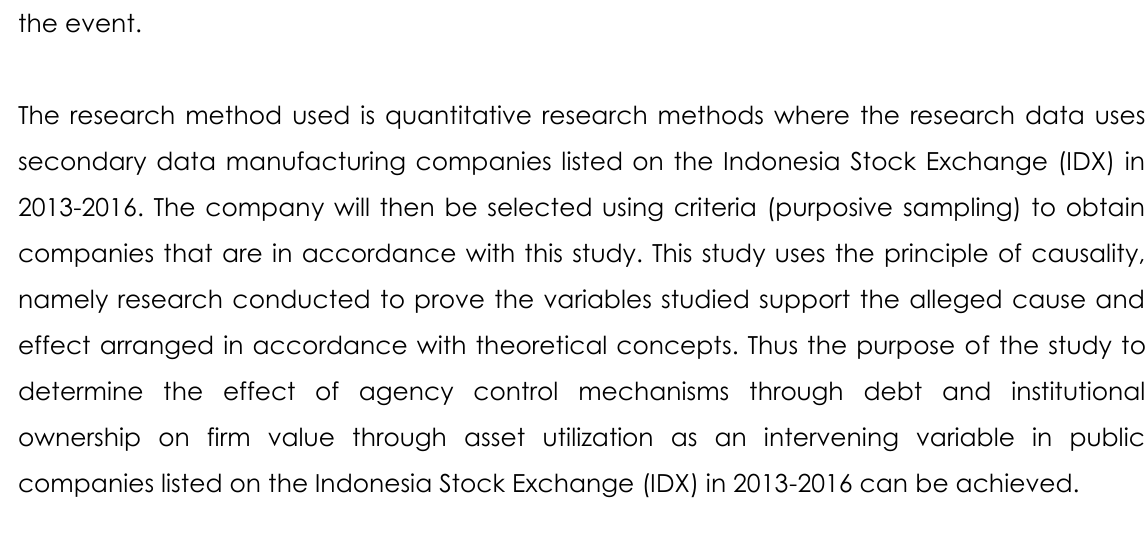
Figure 1. Research